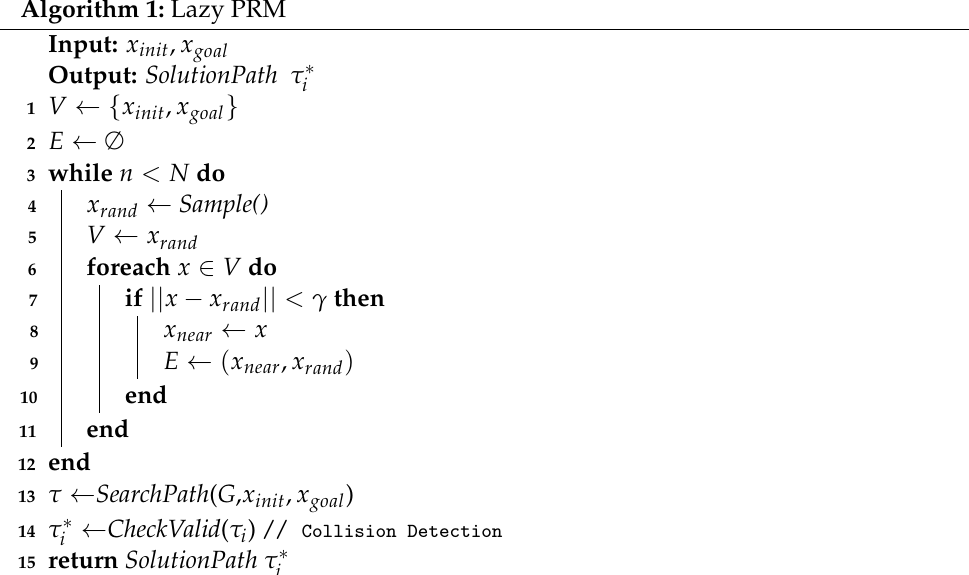
Algorithm 1: Lazy